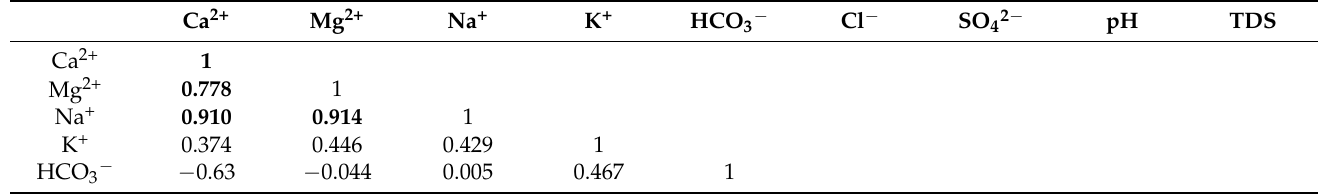
Table 2. Correlation matrix of the groundwater hydrochemical variables.